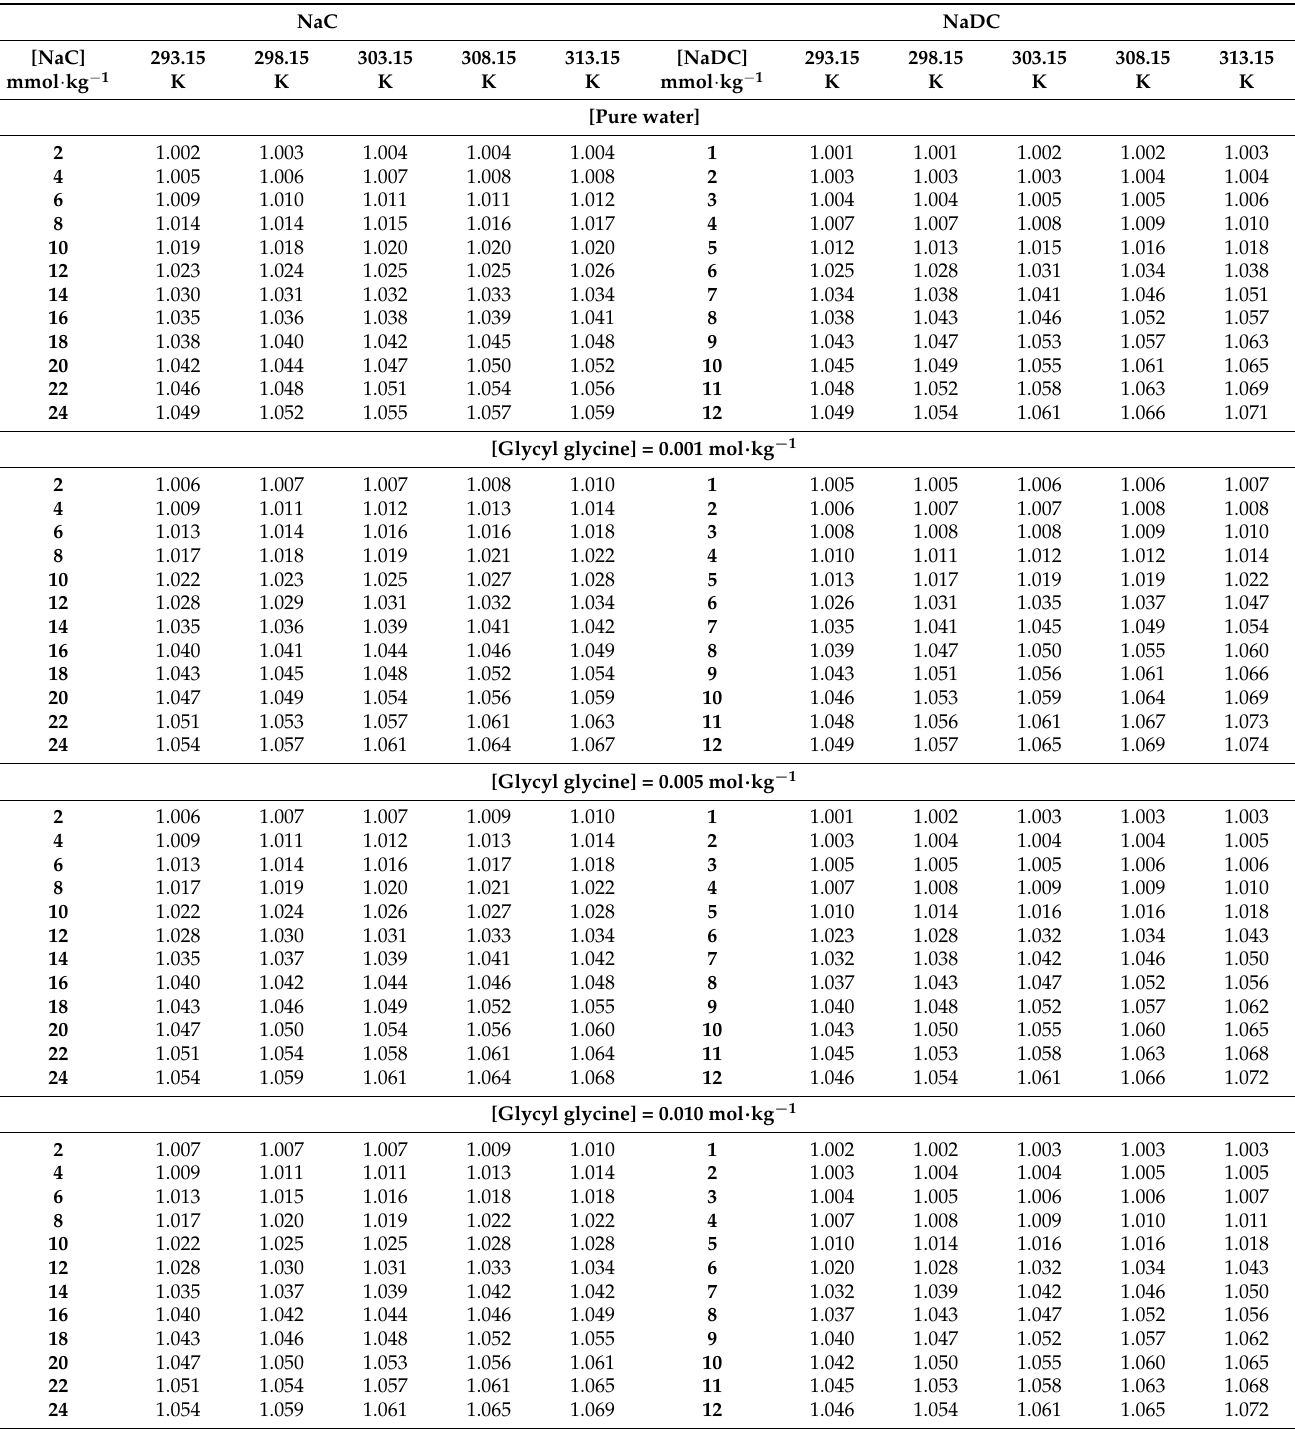
Table 4. Relative viscosity, η r values for NaC and NaDC in pure water and in 0.001, 0.005